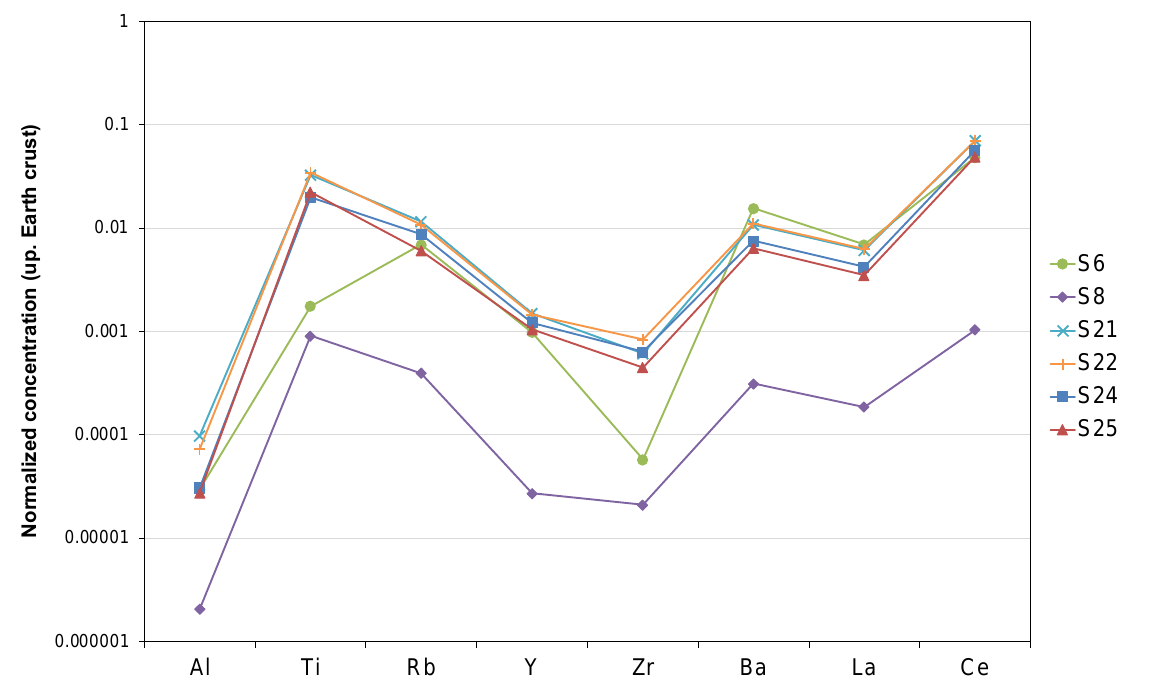
Figure 4. Contents of some trace elements and rare earth elements normalised to the upper Earth crust [31] for the synthesised glasses in logarithmic scale.